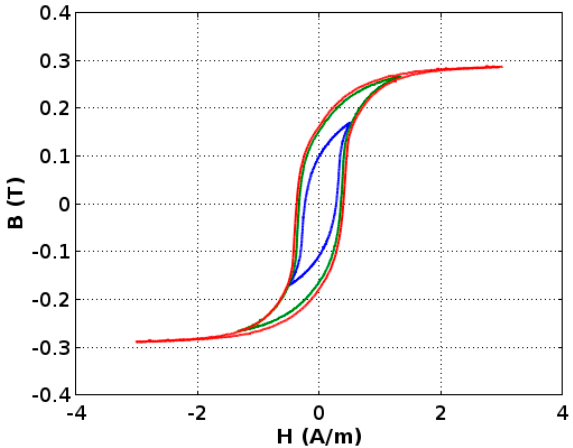
Figure 5. The measurement results for the ring-shaped core made of the amorphous Co 67 Fe 3 Cr 3 B 12 Si 15 alloy was annealed for 1 h at 440 °C in the presence of magnetic field H, which is equal to 40 kA/m applied in the direction of the amorphous alloy ribbon. The maximal points of the minor hysteresis loops follow the normal magnetization curve (blue line—hysteresis loop for magnetizing field H m = 0.5 A/m; green line— H m = 1.5 A/m; red line— H m = 3 A/m).